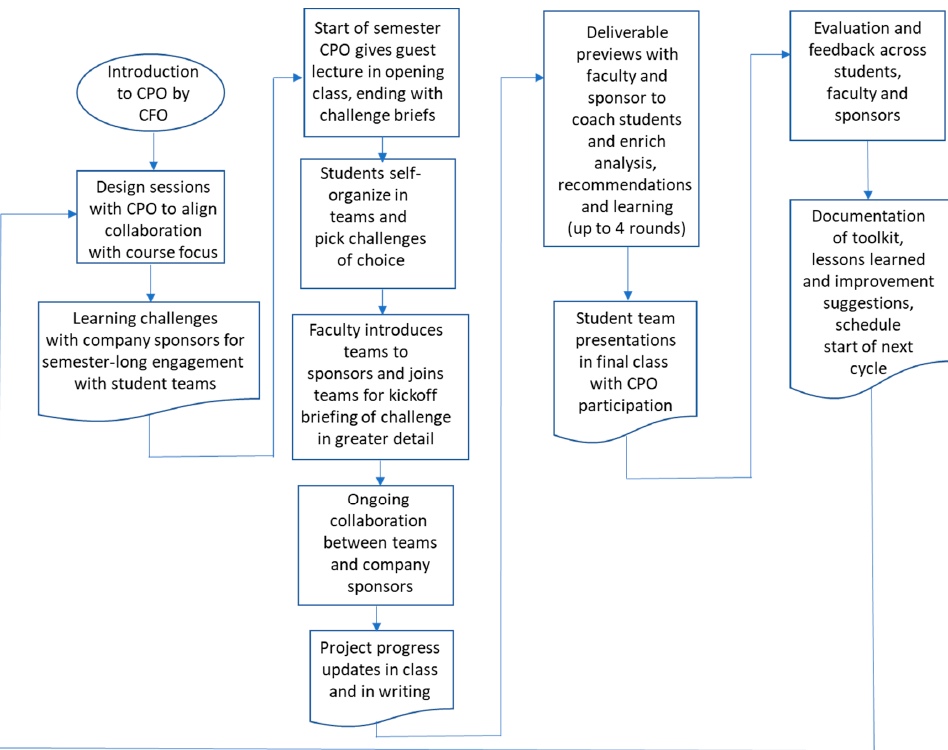
Figure 1. Flowchart for the collaboration design.